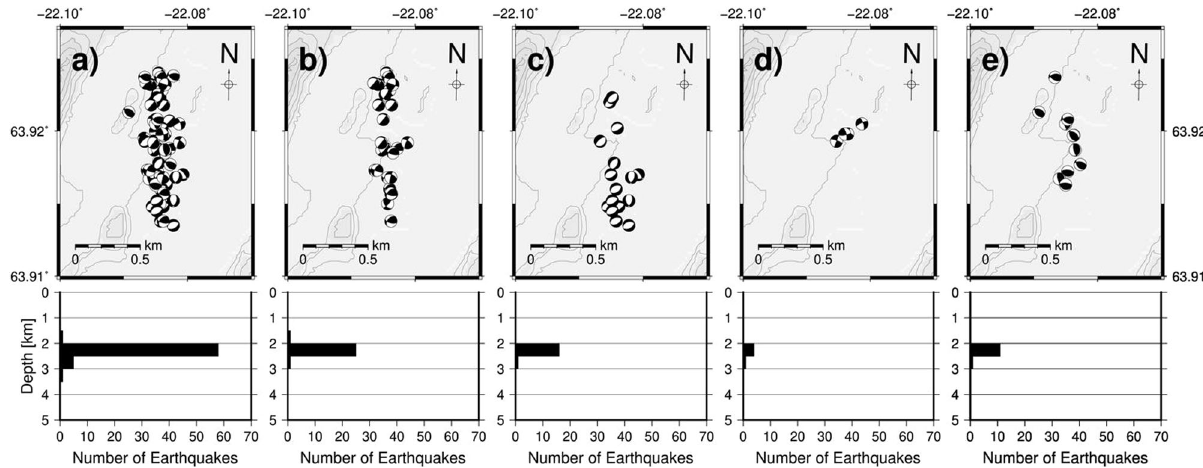
Fig. 3 Focal mechanisms from the shallow Nupshlidarhals seismic swarm. Magnitudes of 64 events from the seismic swarm (occurring 31.7 – 1.8, 2009; location in Fig. 2b) range from 0.18 to 2.09. The focal mechanisms were categorized into different groups depending on which of the P, B, or T axis was closest to vertical: a all data set; b oblique; c extensional; d strike-slip; and e reverse.